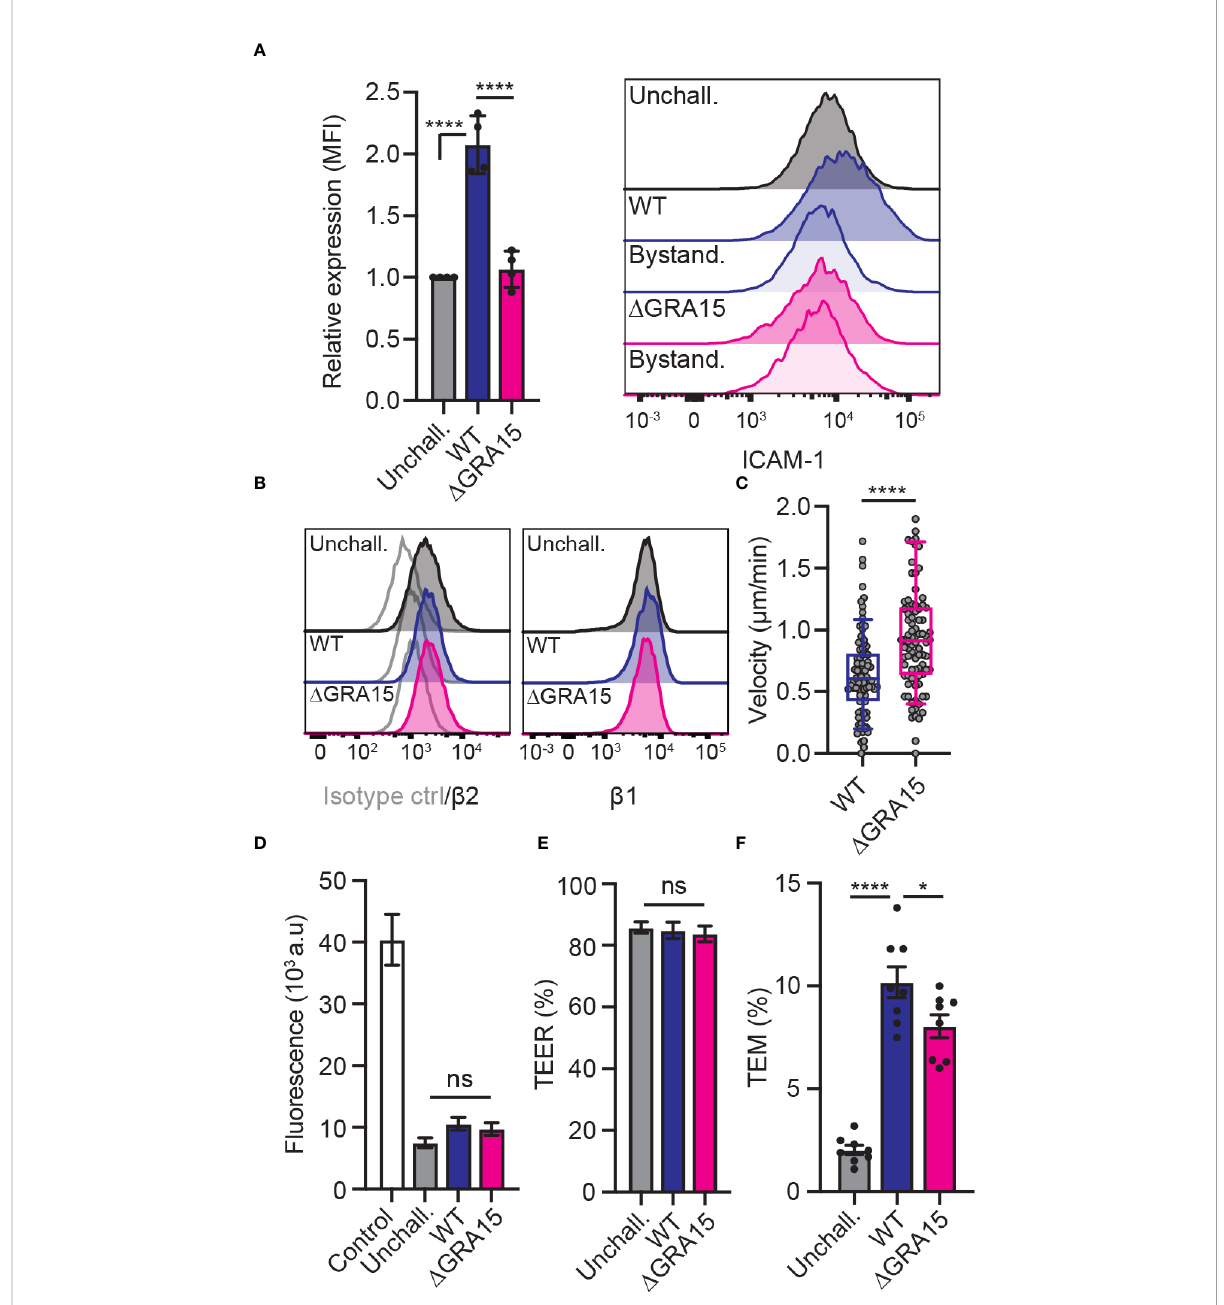
FIGURE 4 Impact of the effector GRA15 on ICAM-1 expression, motility and TEM of DCs. (A) Relative expression of ICAM-1 (CD54) at 24 h post-challenge of CD11c + cells with T. gondii tachyzoites (GFP-expressing PRU WT or PRU D GRA15, MOI 1), assessed by fl ow cytometry. Mean fl uorescence intensity (MFI) was related to that of unchallenged CD11c + in complete medium (CM, normalised to 1). Histogram shows fl uorescence intensity distributions for indicated cell populations. (B) Histograms show fl uorescence intensity distributions of b 2, b 1 integrin and isotype antibody control for indicated cell populations, respectively, and are representative of 3 independent experiments. (C) Box-and-whisker and scattered dot plots represent median velocities of WT-challenged or D GRA15-challenged DCs ( m m/min). Grey circles represent velocities from individual cells. 90 cells were tracked per condition, from 3 independent experiments. (D) Permeability of bEnd.3 cell monolayers to FITC-dextran (3 kDa) following TEM of unchallenged, WT-challenged or D GRA15-challenged DCs. (E) TEER values of bEnd.3 cells relative to TEER values at initiation of the assay (100%). (F) TEM frequencies of unchallenged, WT-challenged or D GRA15-challenged DCs across bEnd.3 cell monolayers shown as percentage (%) of DCs added in the upper well. Bar graphs represent the mean ± s.e.m of 4 independent experiments. * P < 0.05, **** P < 0.0001, ns: non-signi fi cant, by one-way ANOVA followed by Sidak ’ s post-hoc test (A, D, E, F) or Student ’ s t -test (C)